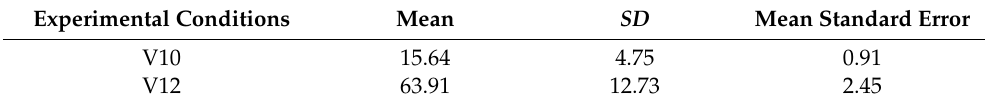
Table 7. Maze experiment runtimes.